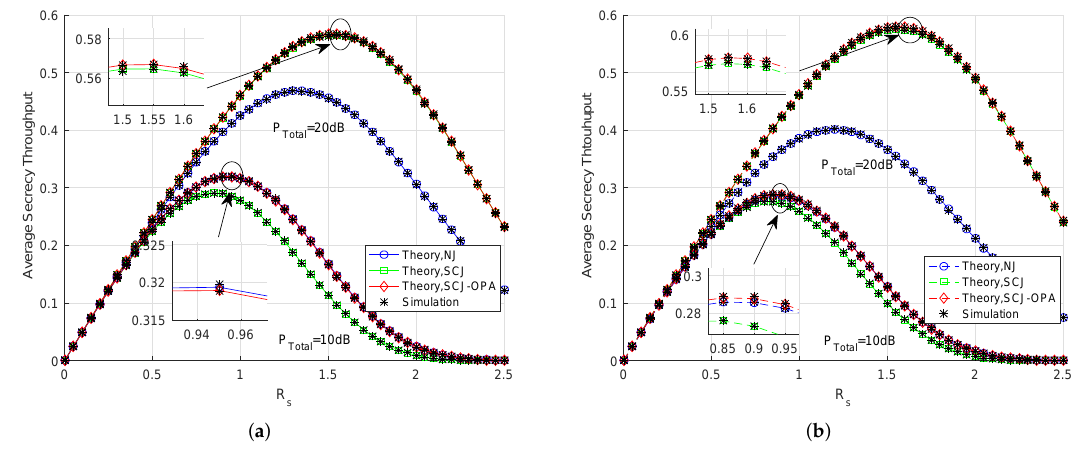
Figure 4. Average Secrecy throughput vs. the secrecy rate R s for the three proposed transmission schemes under the NCE ( a ) and CE ( b ) scenarios when M = 2, L = 3, K = 2, P Total = 10, 20